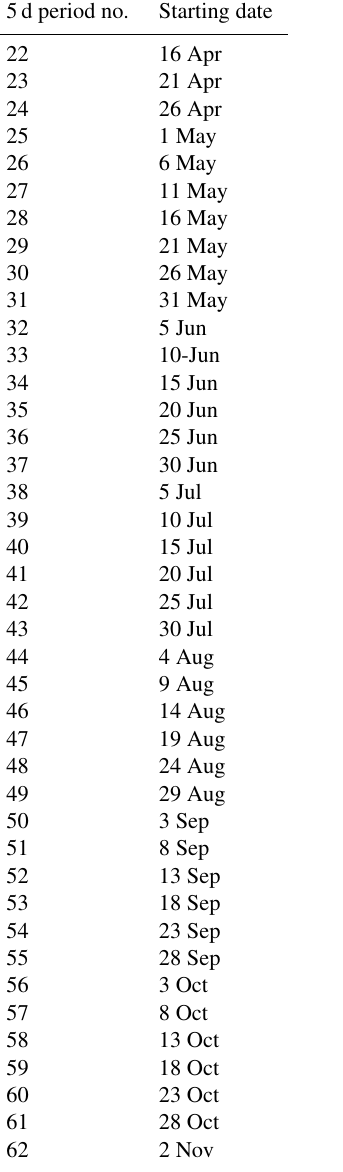
Table 2. Look-up table of 5d periods during the annual common time window.